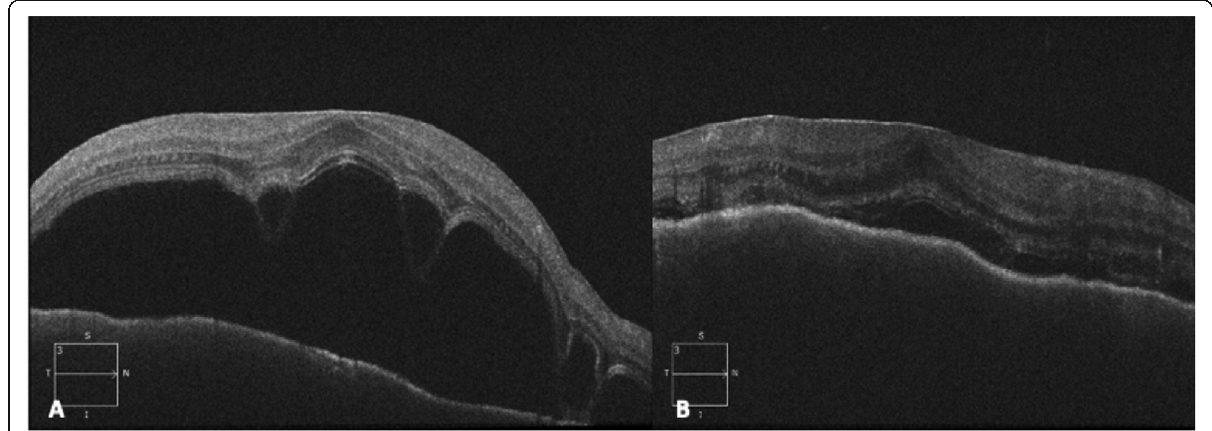
Fig. 2 a Optical coherence tomography of the right eye demonstrating a large macular serous detachment. b Optical coherence tomography of the right eye demonstrating improvement in macular serous detachment after